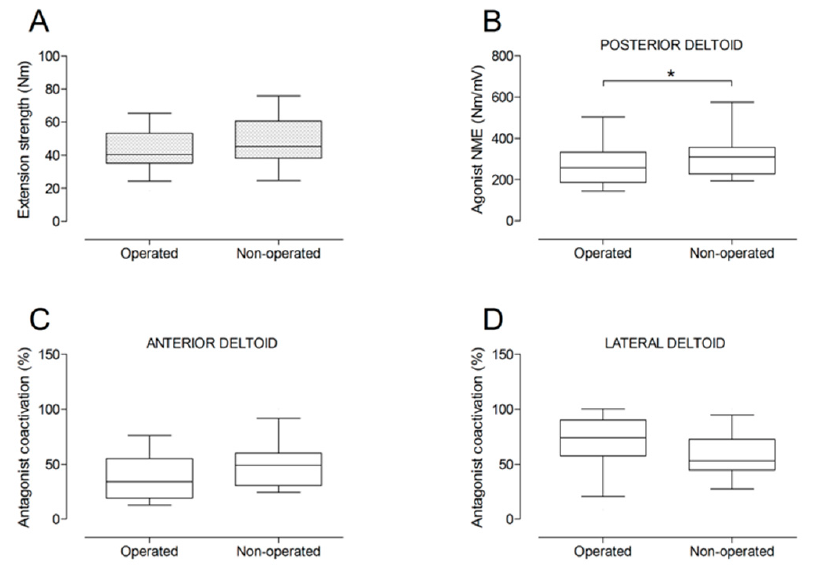
Figure 7. Box and whisker plots of shoulder extension strength ( A ), agonist neuromuscular efficiency (NME) of posterior deltoid muscle ( B ), antagonist coactivation of anterior deltoid ( C ) and lateral deltoid ( D ) muscles by side. The horizontal line in the box represents the median, the height of the box represents the interquartile range, and the distance between the opposite ends of the whisker represents the 10th–90th percentile. *Operated < non-operated ( p < 0.05).